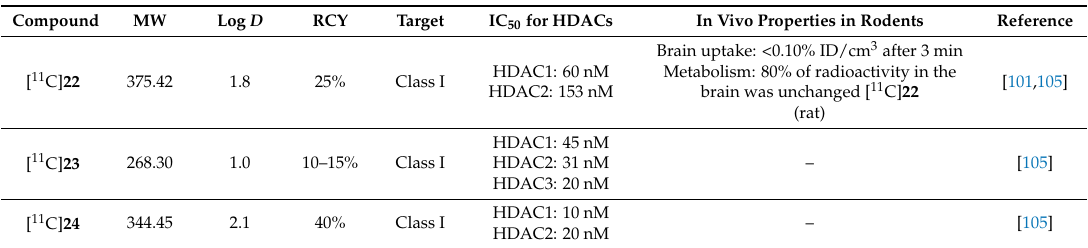
Table 4. Physiochemical properties of radiolabeled benzamide-based HDAC ligands.